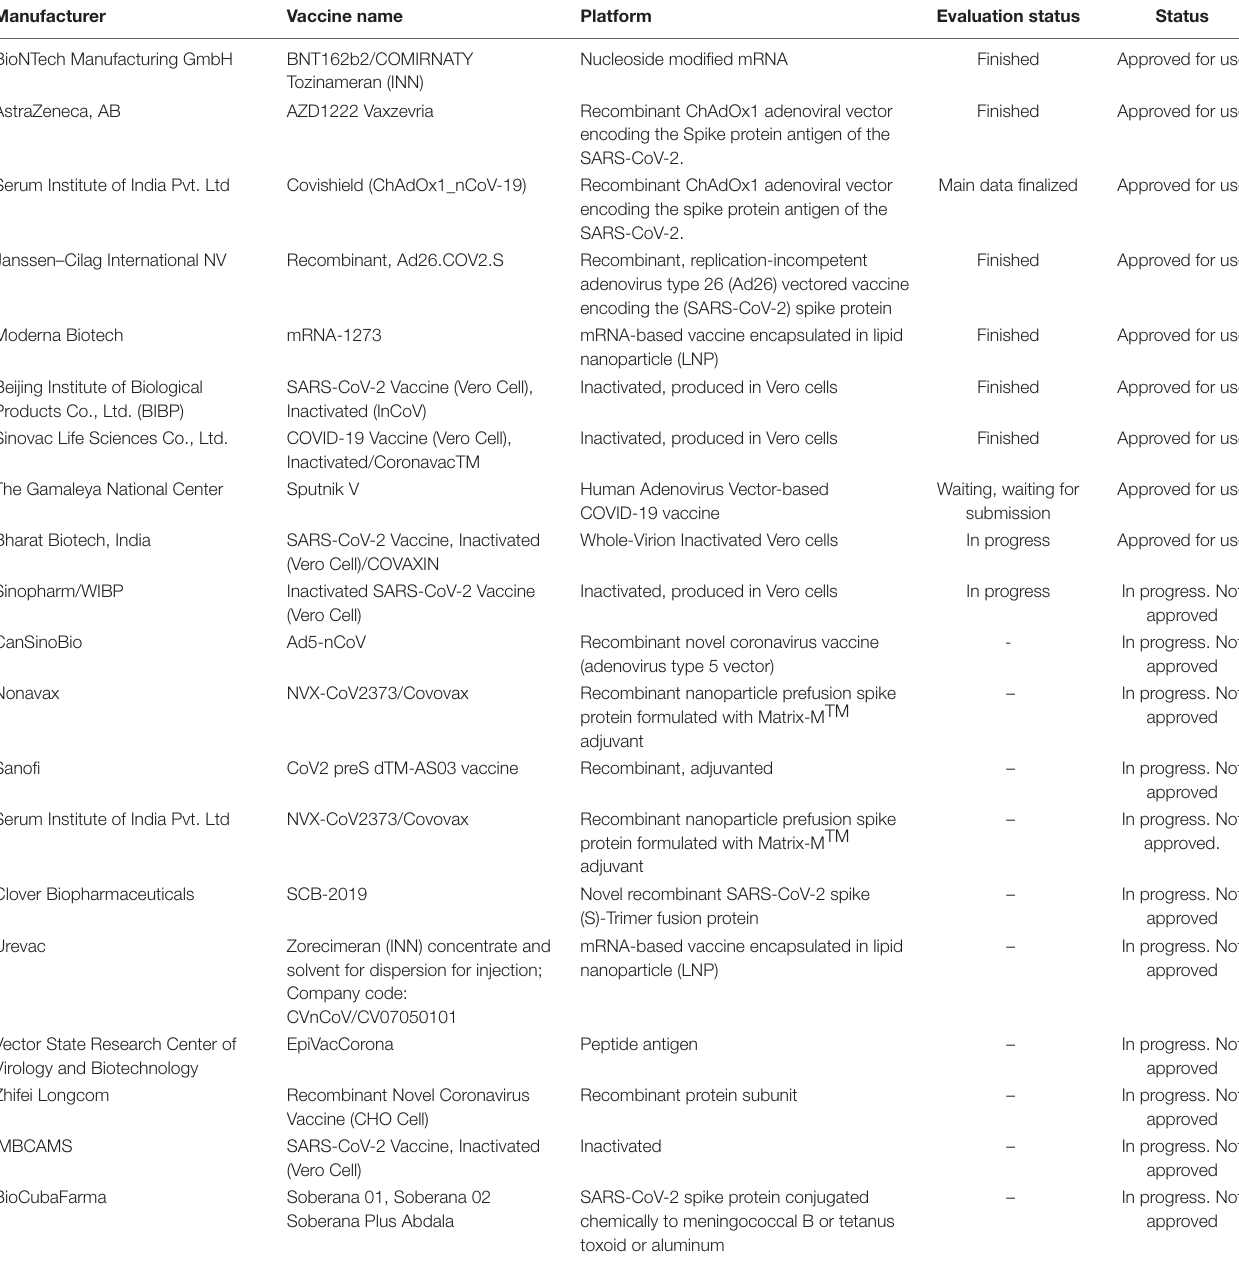
TABLE 6 | Vaccines available and in development for protecting against